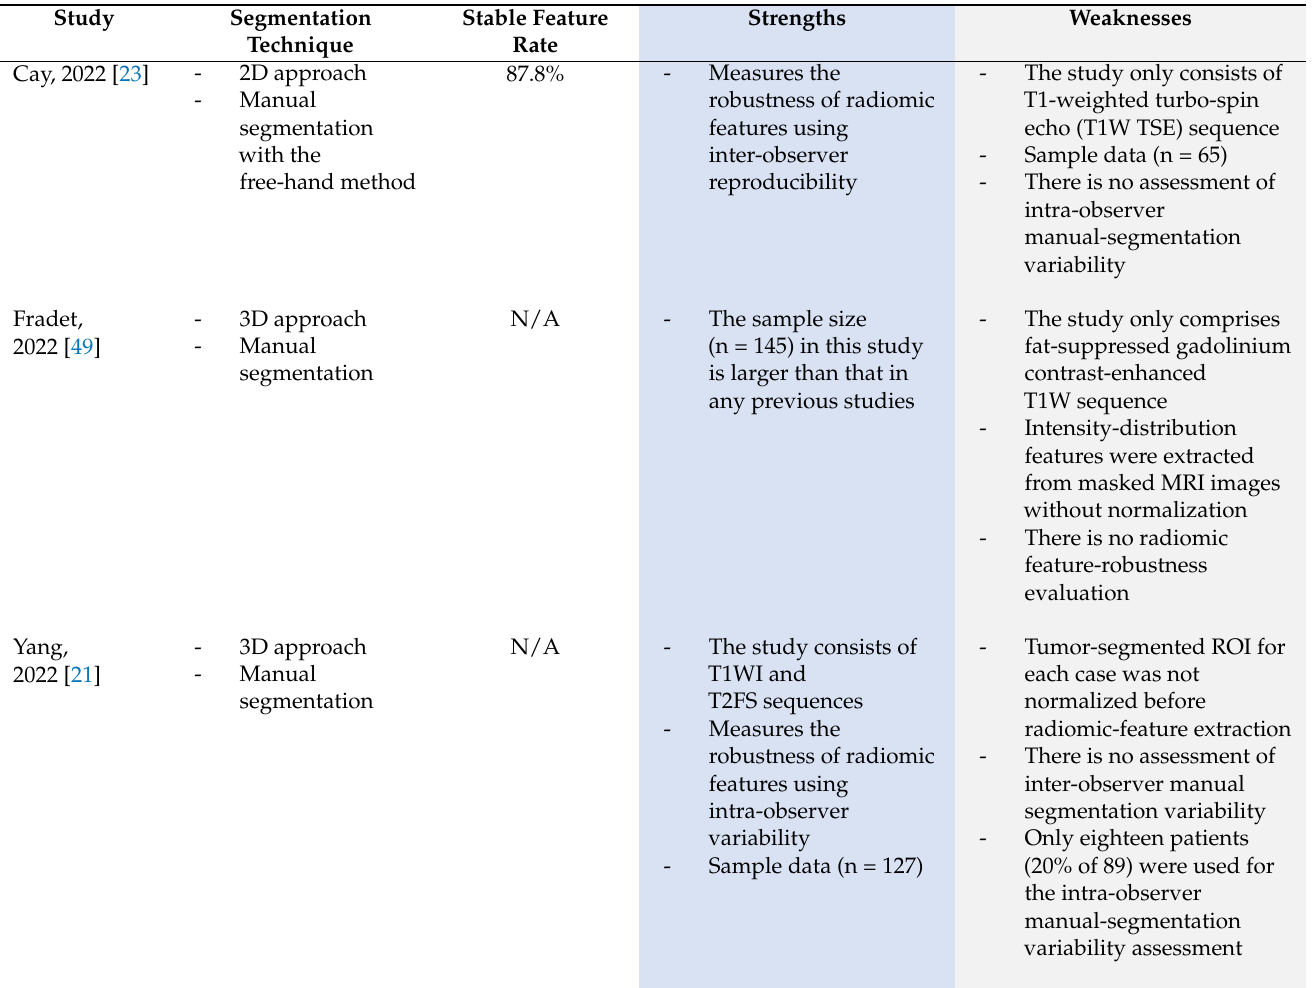
Table 6. Summary of the literature and current study for MRI-based radiomic-feature robustness in lipomatous soft-tissue